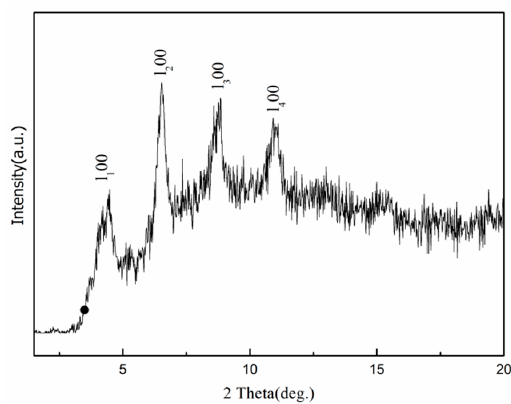
Figure 4. X-ray diffractometer (XRD) pattern of the superhydrophobic surface generated by pulse electrodeposition under 60% duty ratio.